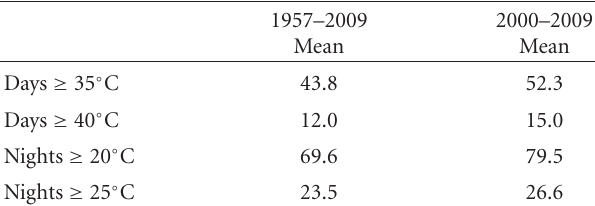
Table 3: What happens when you get too hot?